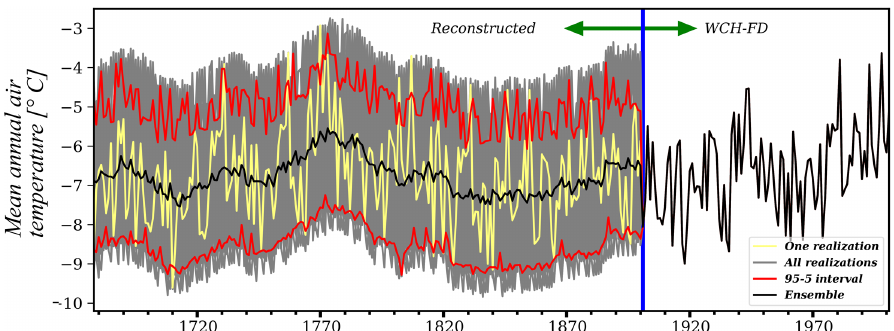
Figure 7. Combined air temperature time series generated using the block-bootstrapping technique and WCH-FD. The time series is divided in two periods. From 1678–1900 the temperature and the other six climate variables were generated using the block-bootstrapping technique with a block of 5 years assembled on tree-ring-based reconstructions. The 100 realizations (grey lines), the 5–95% confidence interval (red lines), and the average of the ensemble (black line) are shown. In the second period (1901–2000) the climate variables are used directly from the WCH-FD